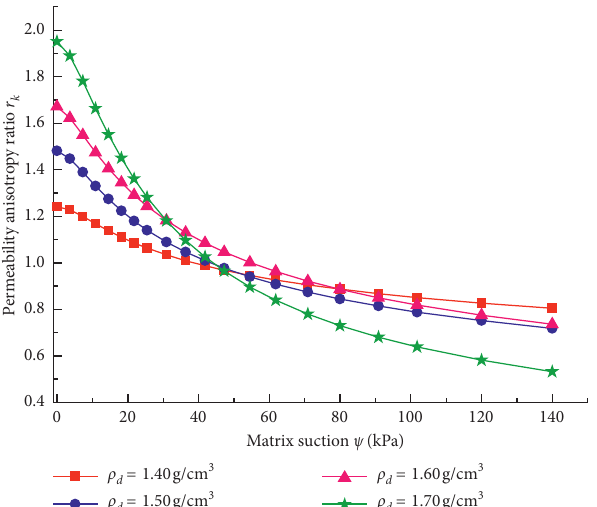
Figure 8: Relationship between permeability anisotropy ratio and matrix suction.